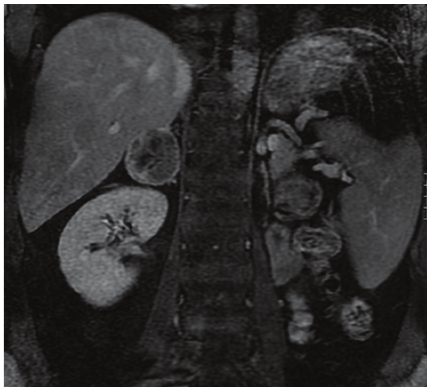
Figure 1: Preoperative magnetic resonance imaging (MRI) of right peri-adrenal tumor.